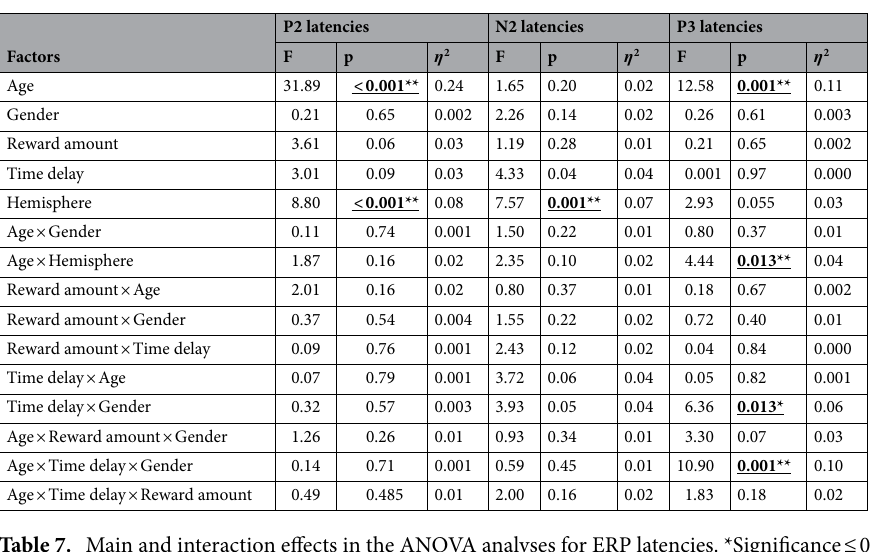
Table 7. Main and interaction effects in the ANOVA analyses for ERP latencies. *Significance ≤ 0.05; **Significance ≤ 0.001.